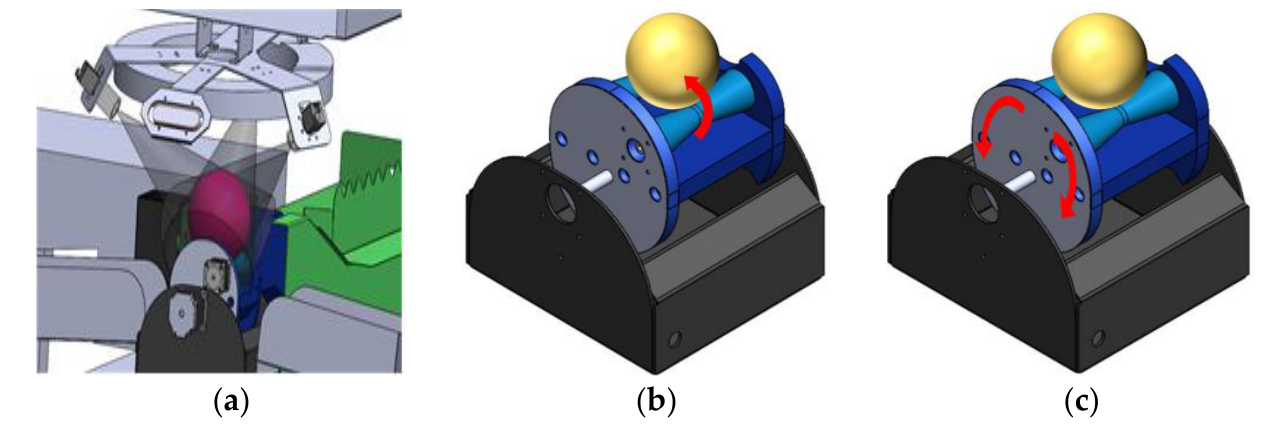
Figure 3. Camera structure and rotation mechanism: ( a ) Camera structure; ( b ) Stepping motor for apple rotation; ( c ) Apple sorting based on the results of a CNN classifier.